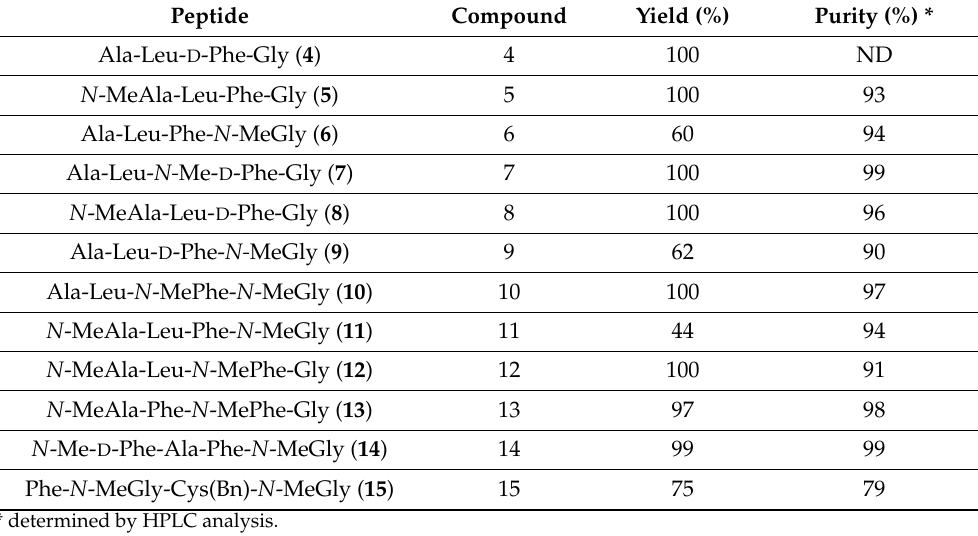
Table 1. Linear peptides obtained by Fmoc- SPPS.